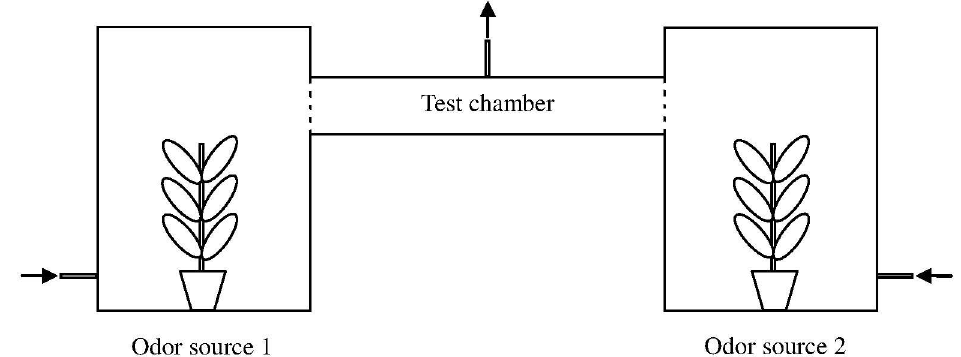
Fig 1. The apparatus for testing the dual-choice responses of ovipositing females. Potted plants or their combinations were placedin the two vertical cylinders,and test moths were released into the test chamber. Dotted lines betweenthe test chamberand the two vertical cylindersindicate two pieces of cotton gauzecovered at both ends of the test chamber, which were used as ovipositionalsubstrate. Arrows indicate directions of air